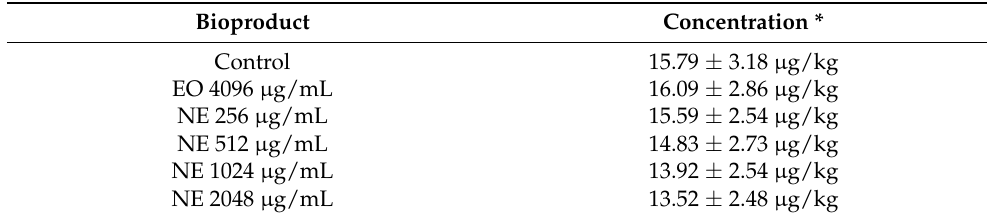
Table 11. AFB1 production by A. westerdjikiae colonies in the presence of EO and NE at 48, 72, and 96 h.